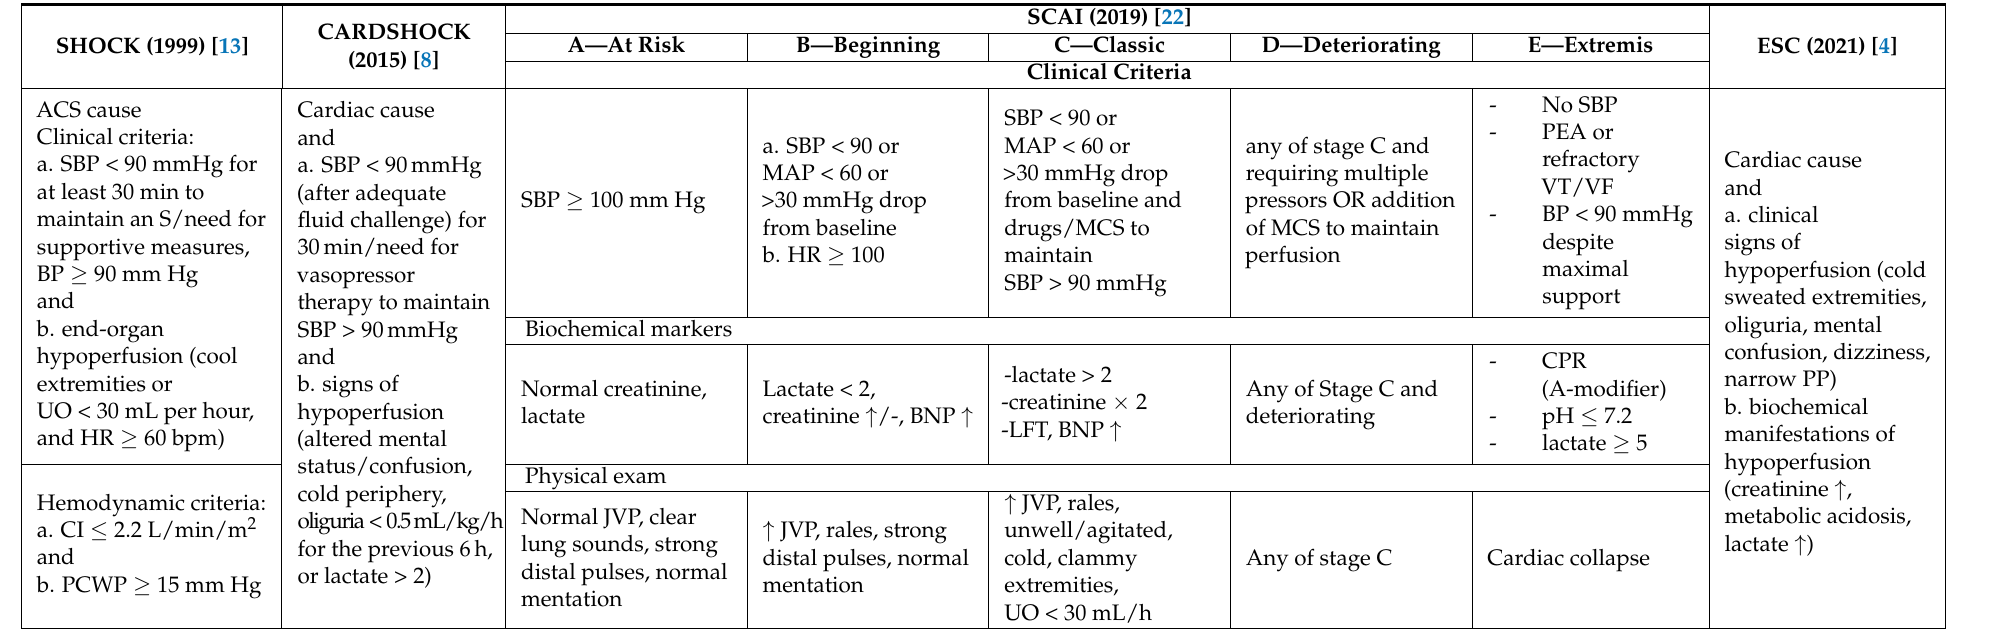
Table 1. Definition of Cardiogenic Shock in various clinical trials and